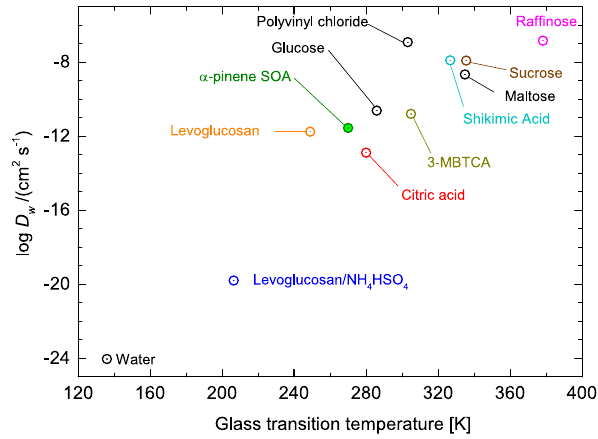
Figure A3. Water diffusivity at the glass transition temperatures of the pure component model mixtures, D w (T g , 0 ) , and at the glass transition of water, D w (T g , 1 ) , according to Smith and Kay (1999). Also shown are data from the literature for glucose, maltose and polyvinyl chloride (Kumins and Roteman, 1961; Parker and Ring, 1995). The values for shikimic acid, sucrose and raffinose are ex- trapolations of the parameterizations given in Table A1.